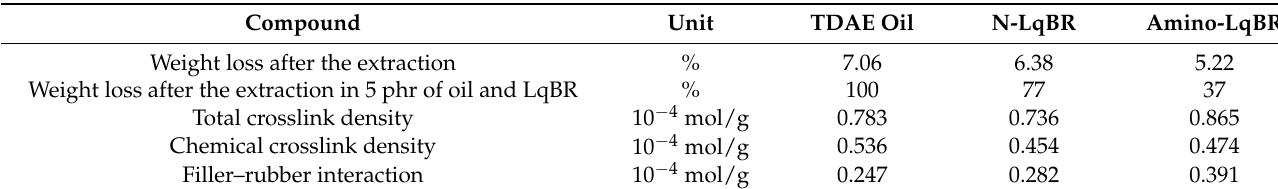
Figure 8. Crosslink density of the vulcanizates.